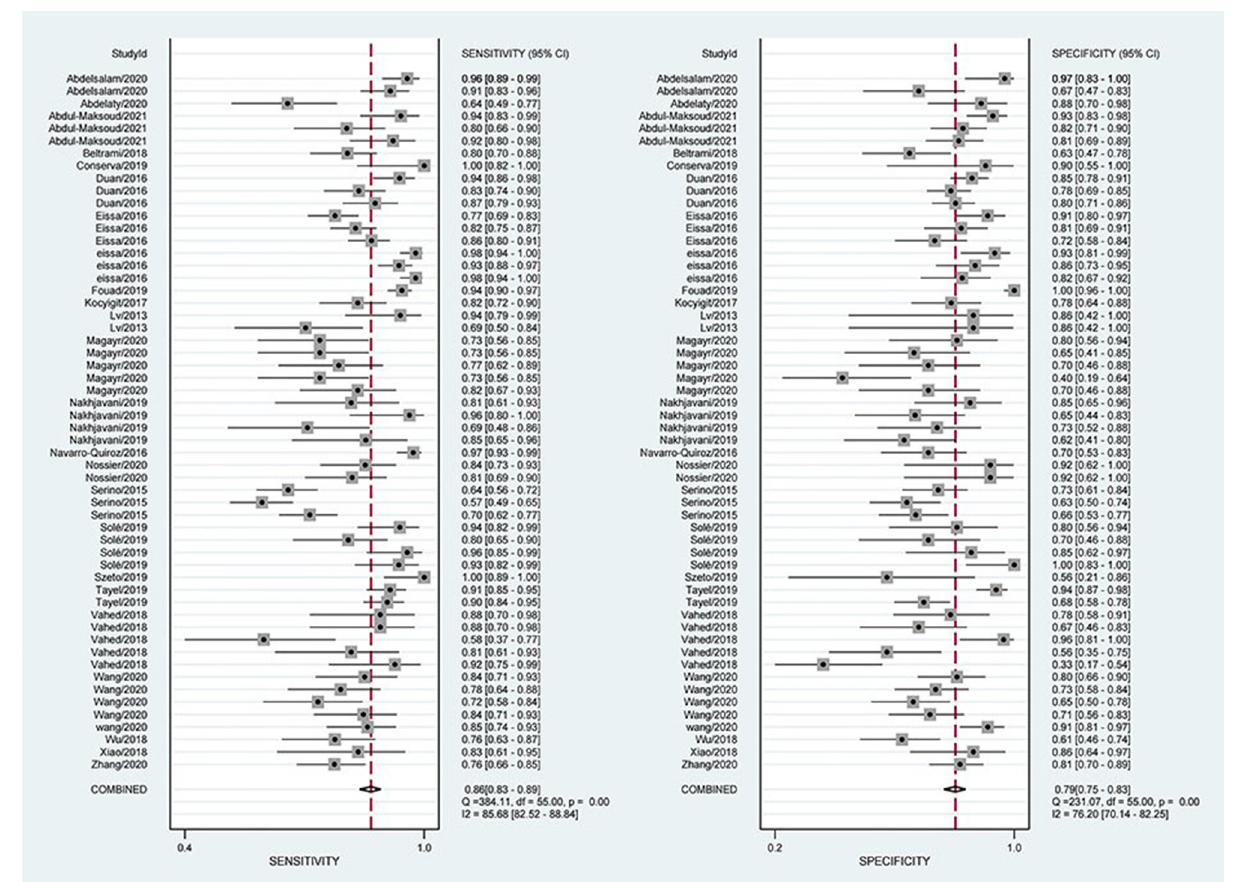
FIGURE 3 | Forest plots of sensitivity and specificity on overall miRNA used in the diagnosis of